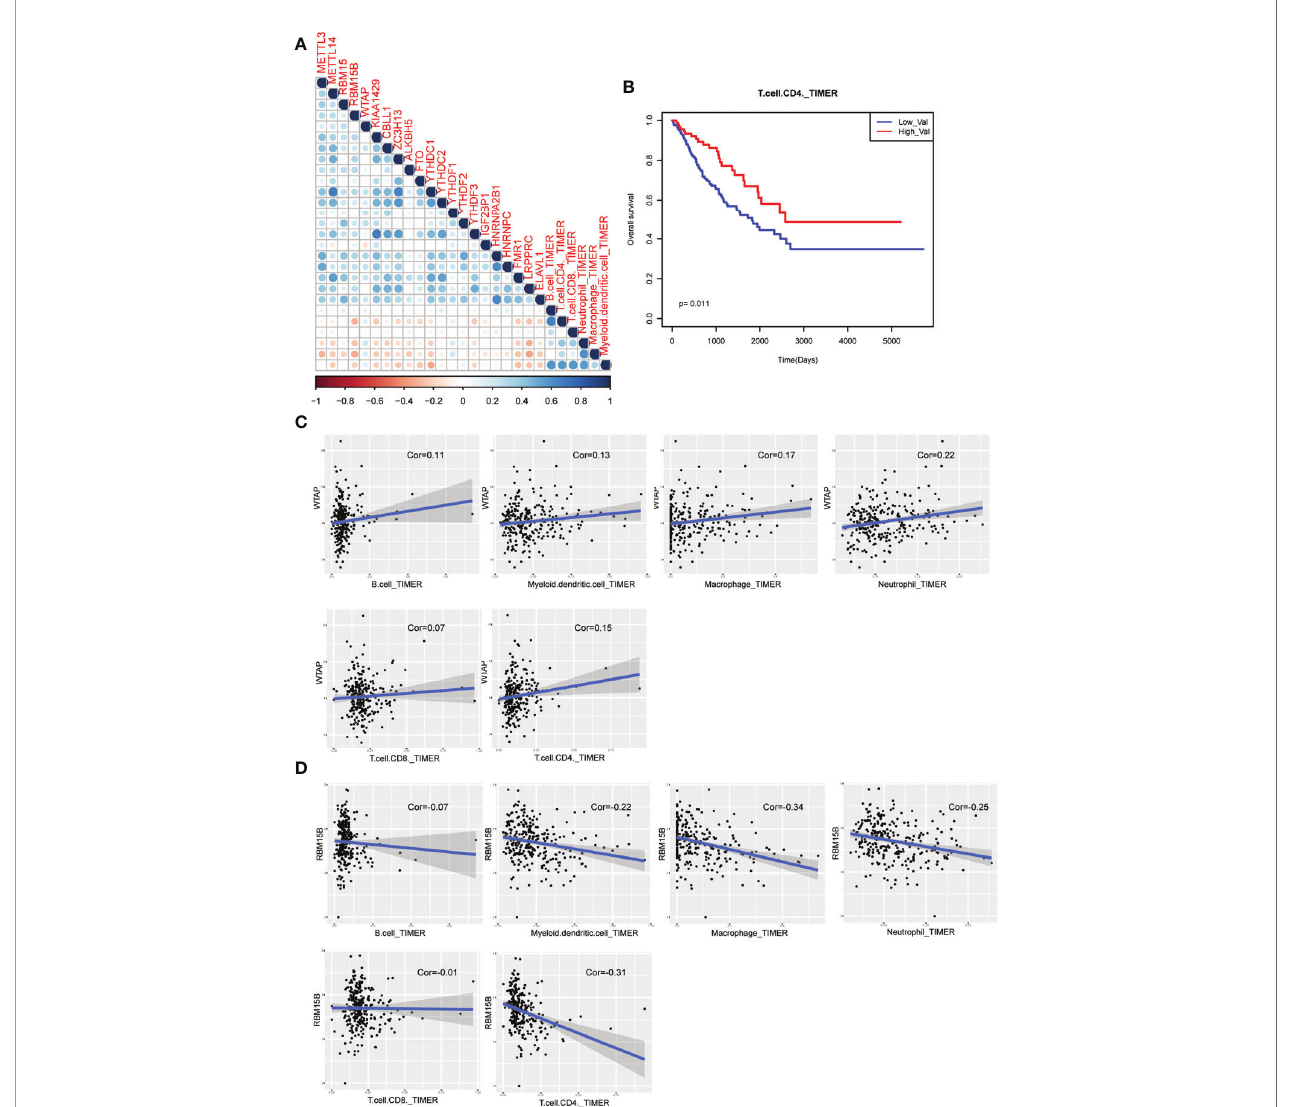
FIGURE 7 | Immune cell in fi ltration of m6A regulators in sarcoma patients. (A) The visualization of correlations between m6A regulator expression and TIMER2 immune cell estimation score. (B) The Kaplan-Meier survival curves of between CD4 T cell-enriched patients and other patients. (C) Scatter plots of correlations between m6A regulator expression and TIMER2 immune cell estimation score (positive correlation). (D) Scatter plots of correlations between m6A regulator expression and TIMER2 immune cell estimation score (negative